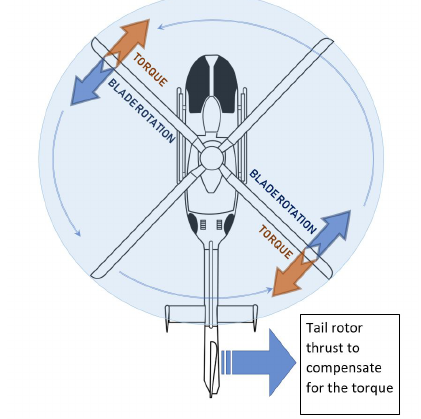
Figure 4. Anti-torque effect of the tail